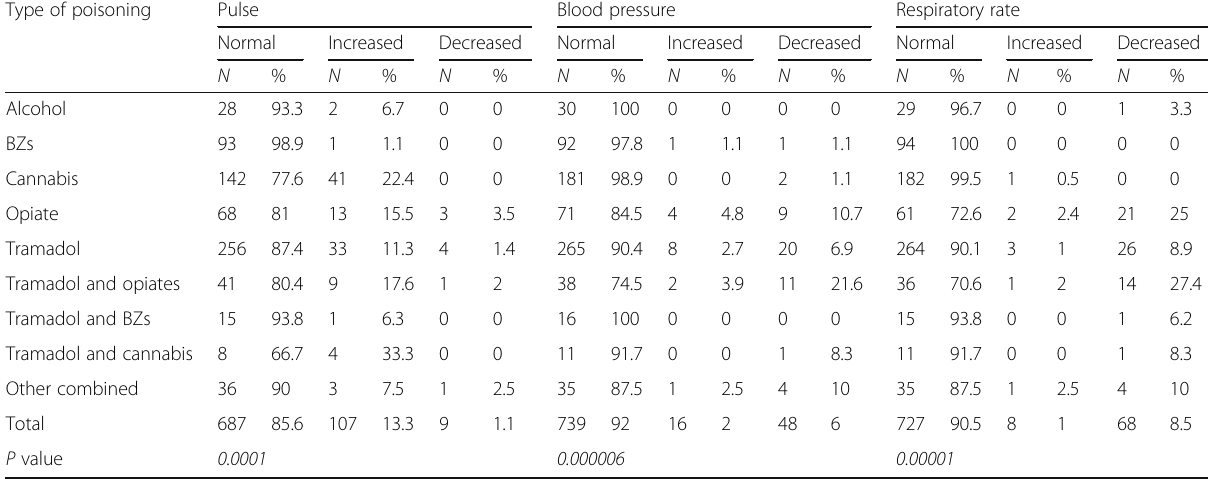
Table 3 Description of vital sign among all patients with different types of poisoning Type of poisoning Pulse Blood pressure